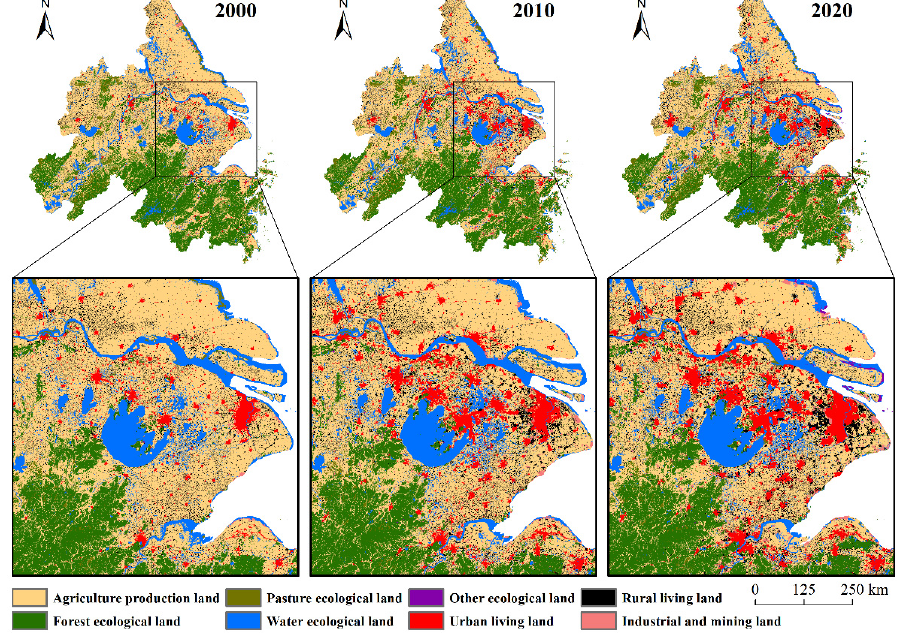
Figure 3. PLES land use of the YRDUA during 2000–2020.